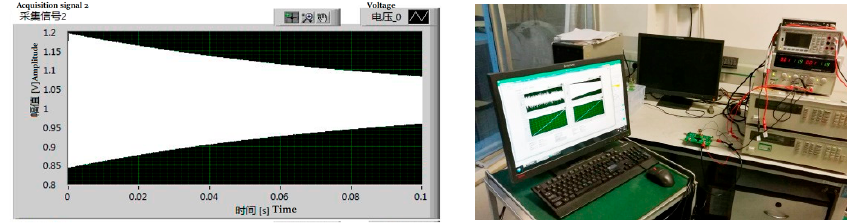
Figure 2. Q-factor test frequency response diagram and test system.